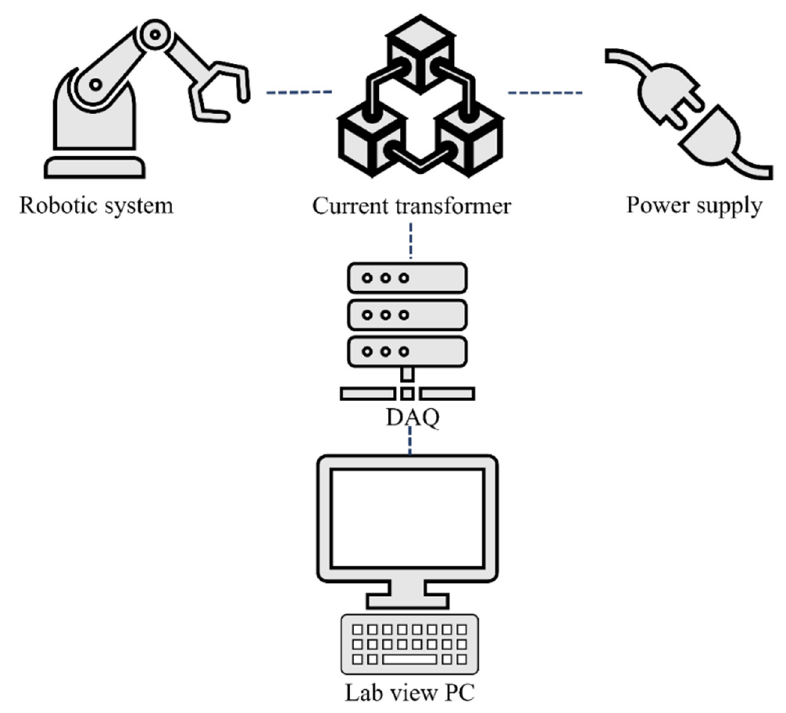
Figure 3. Demonstration of the DAQ system.